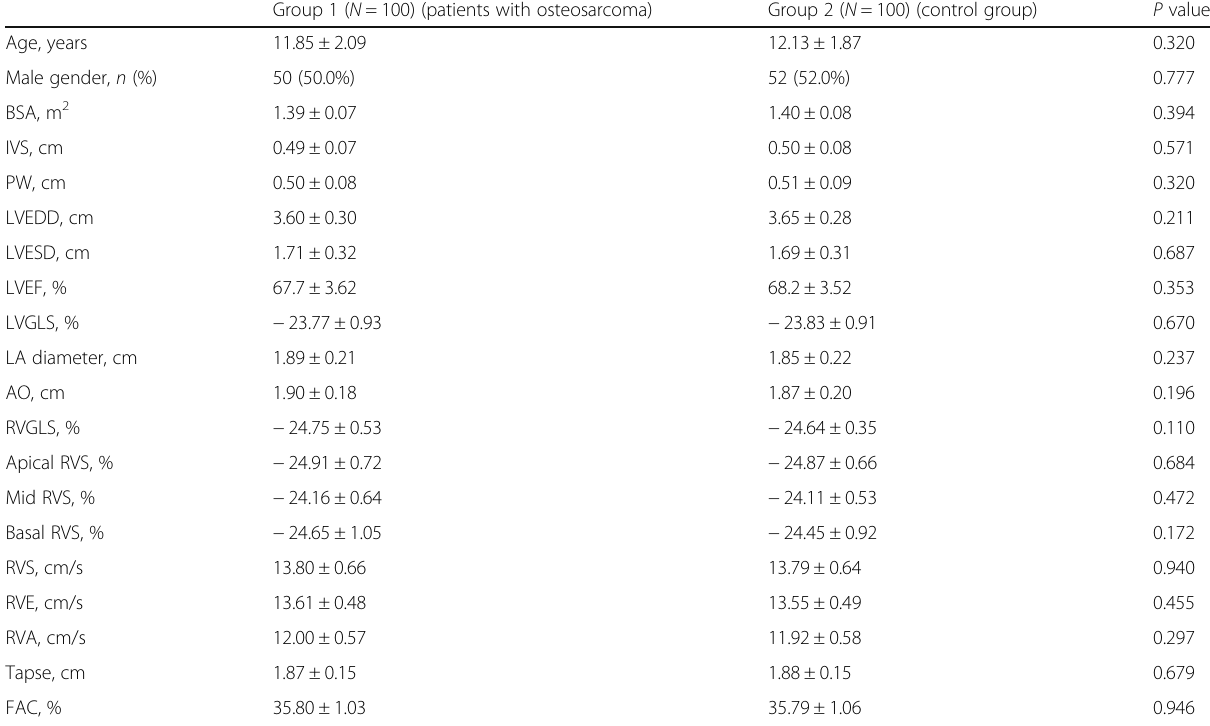
Table 2 Basal characteristics, echocardiographic results, and RV 2DSTE of the two groups Group 1 ( N = 100) (patients with